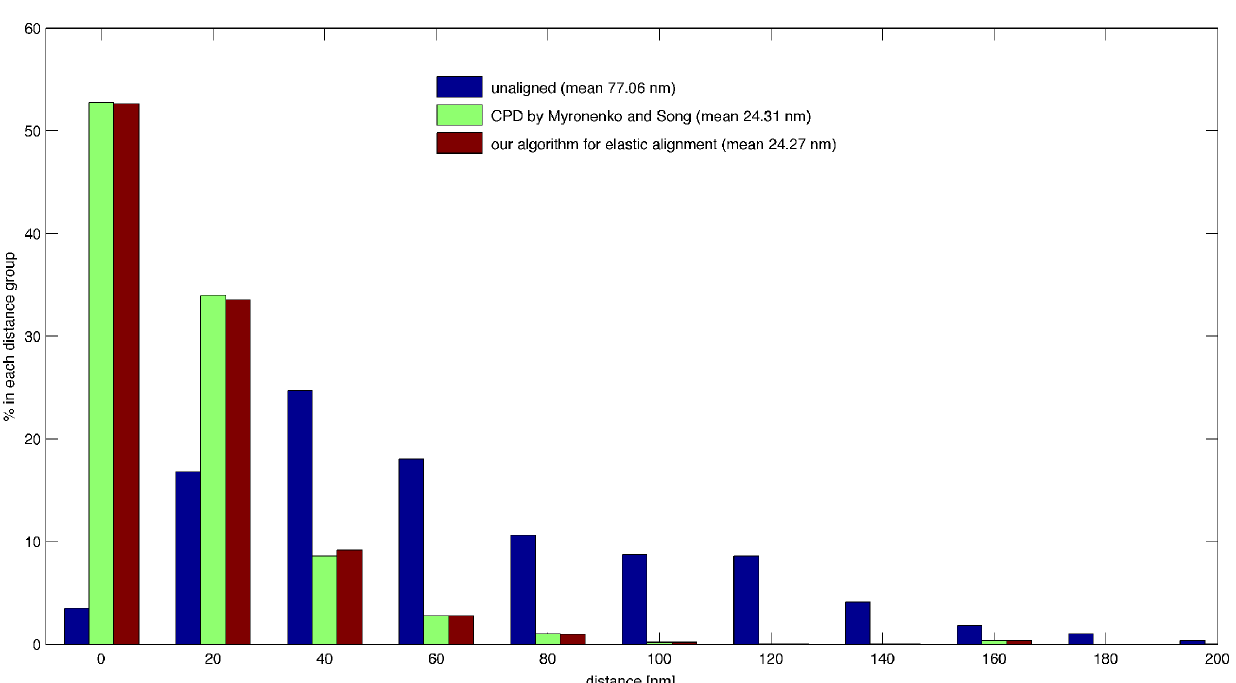
Figure 12. Distances before and after alignment. Histogram of the distances between corresponding endpoints for the X. laevis ground truth before and after applying the non-rigid point set registration algorithm by Myronenko and Song (Figure 4 in [28]) and our algorithm for elastic